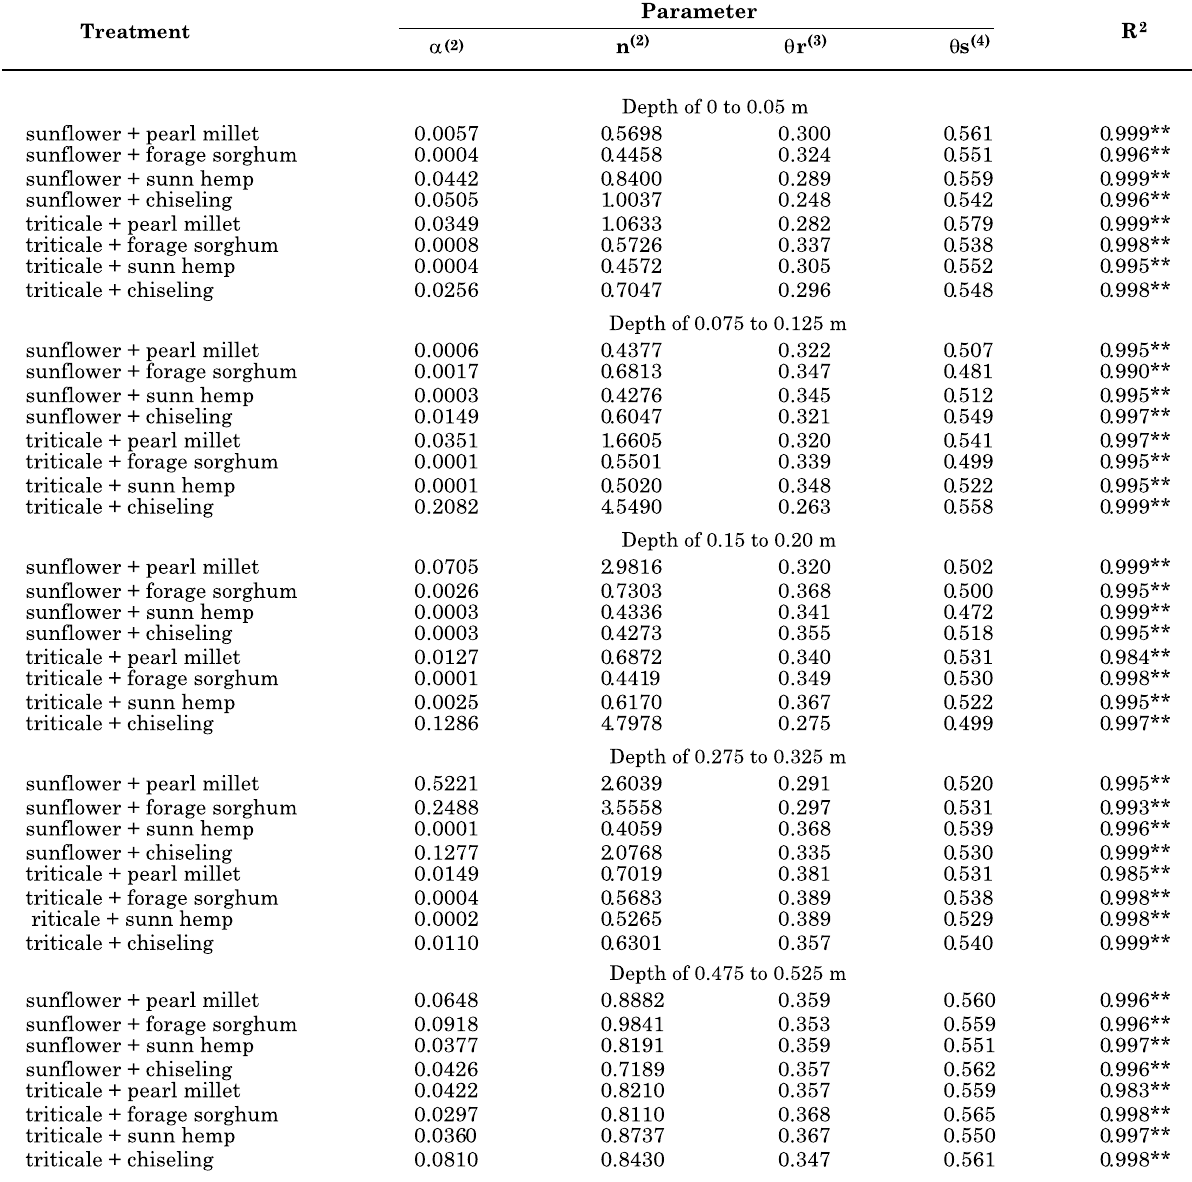
Table 2. Estimated regression coefficients for the water retention curve (WRC) (1) at the at the 0 to 0.05,